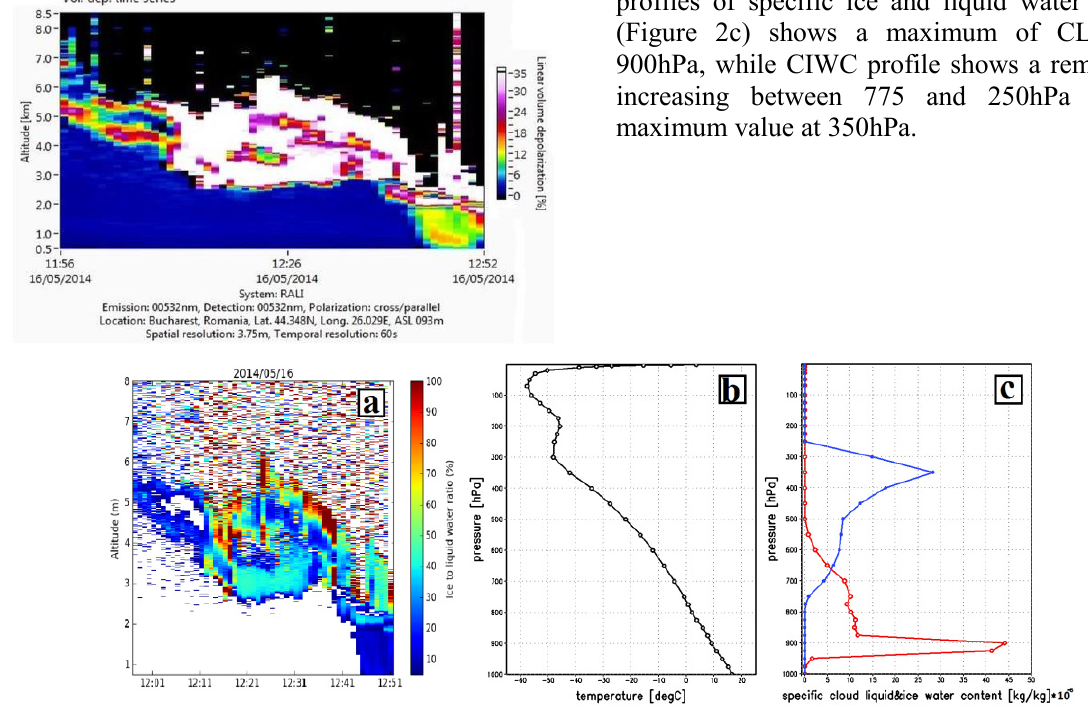
Figure 2 Time series of ice to liquid water ratio from lidar measurements (a), profile of T 0 C (b) and CIWC (blue line) & CLWC (red line) (c) from ECMWF ERA - Interim reanalysis for May 16, 2014